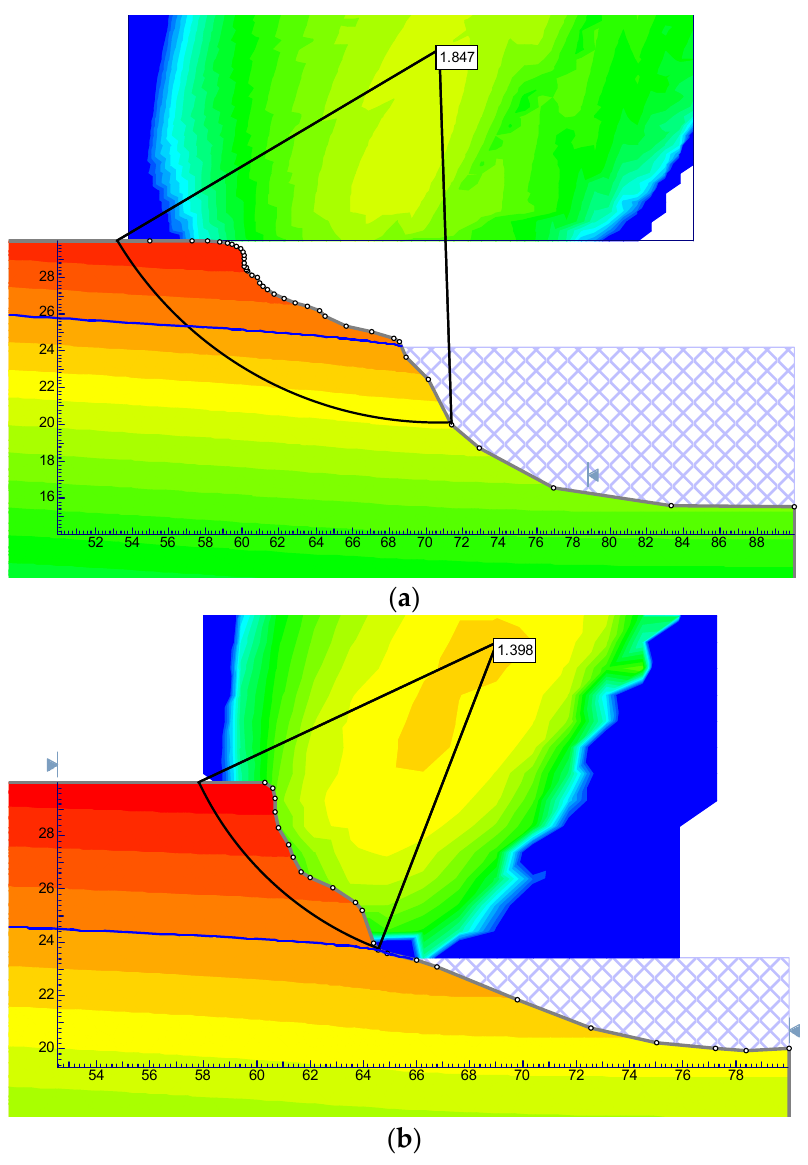
Figure 9. Results of slope stability analysis under 57 m 3 /s steady state flow: ( a ) Site 1, and ( b ) Site 4.